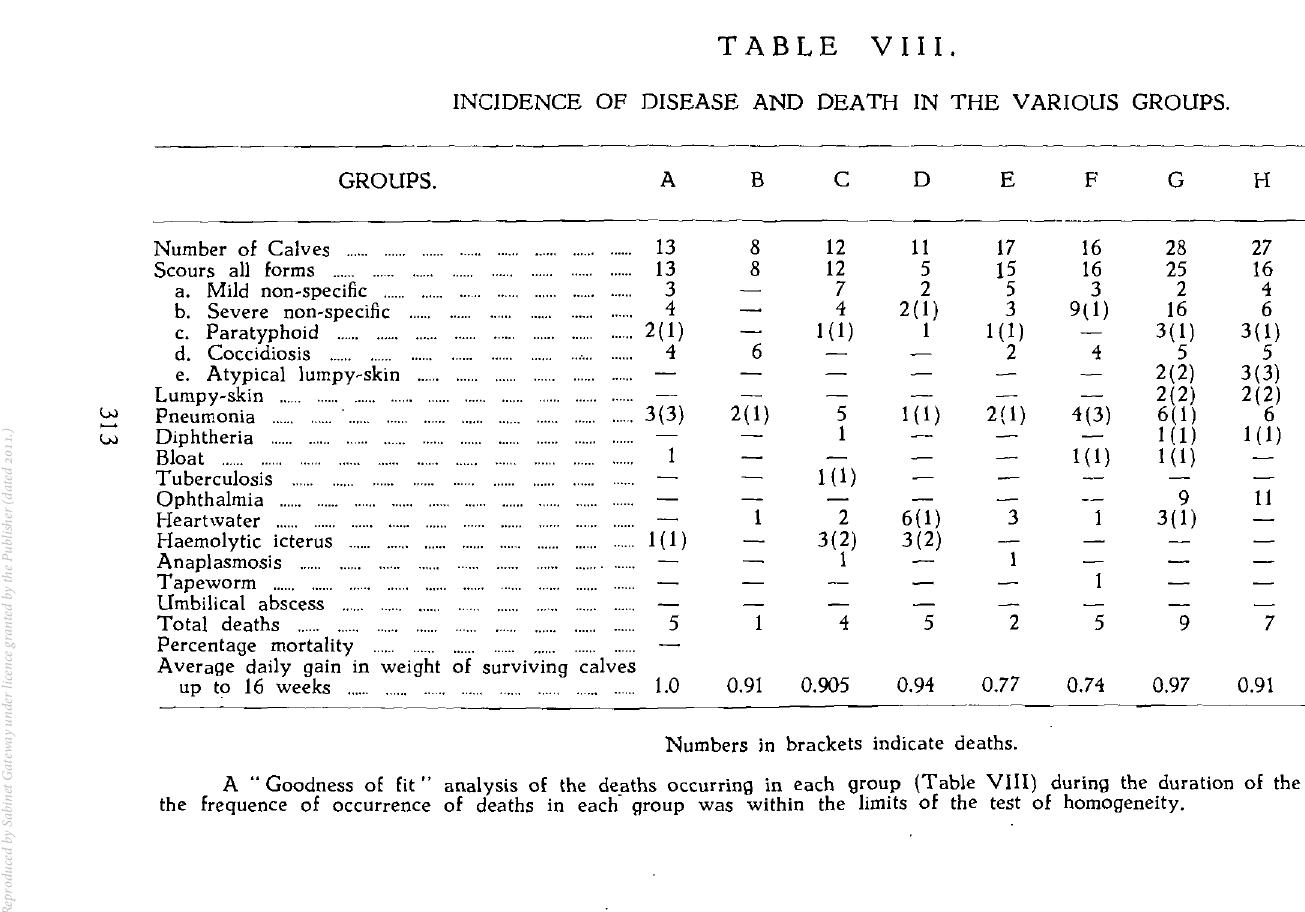
INCIDENCE OF DISEASE AND DEATH IN THE VARIOUS GROUPS.